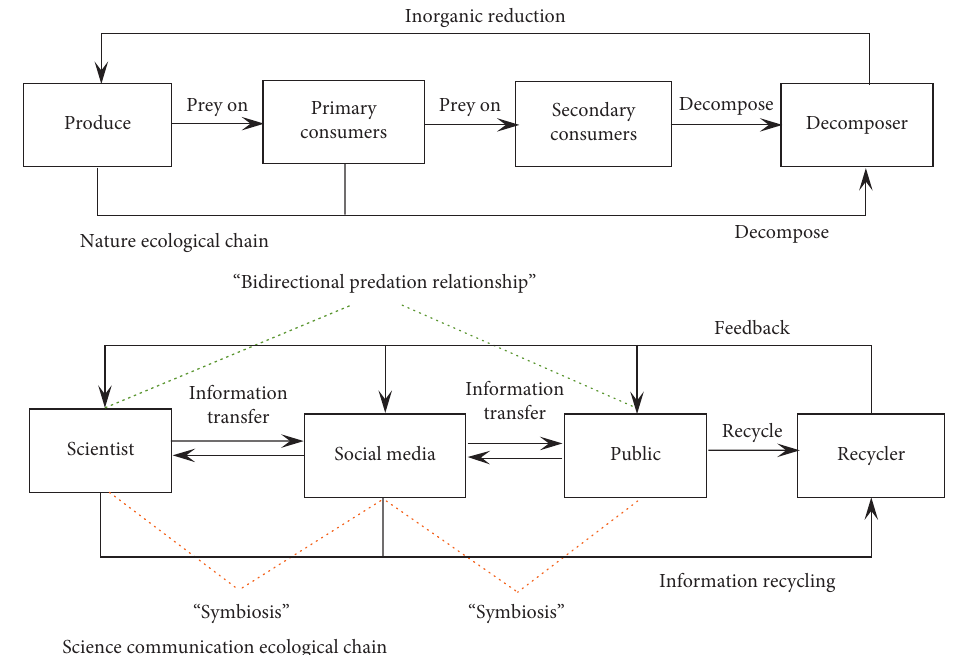
Figure 2: Comparison between nature ecological chain and science communication ecological chain. The direction of the arrow indicates the direction of information or energy flow, and the dashed line indicates the relationship between the two sides.